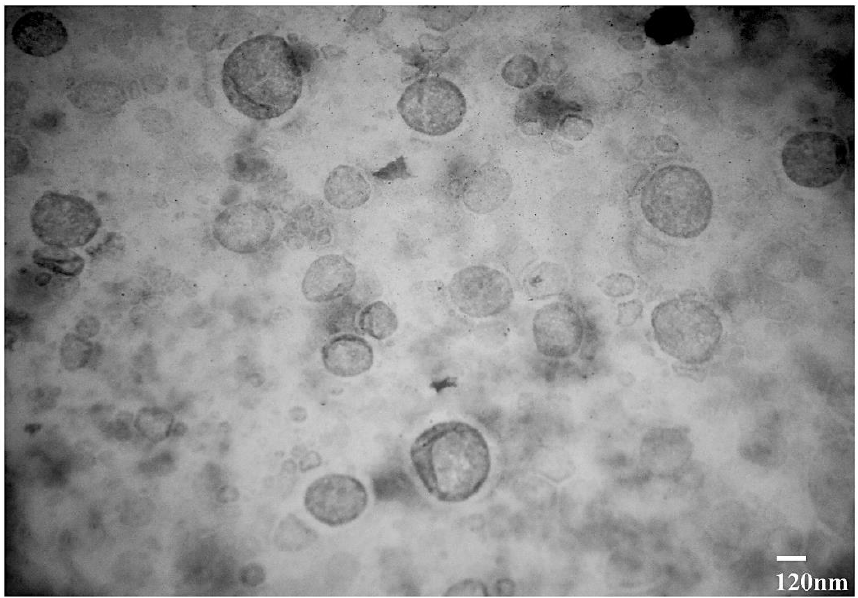
Figure 2. TEM micrograph of the optimized TAEG formulation (TA-5). Scale bar is indicated.